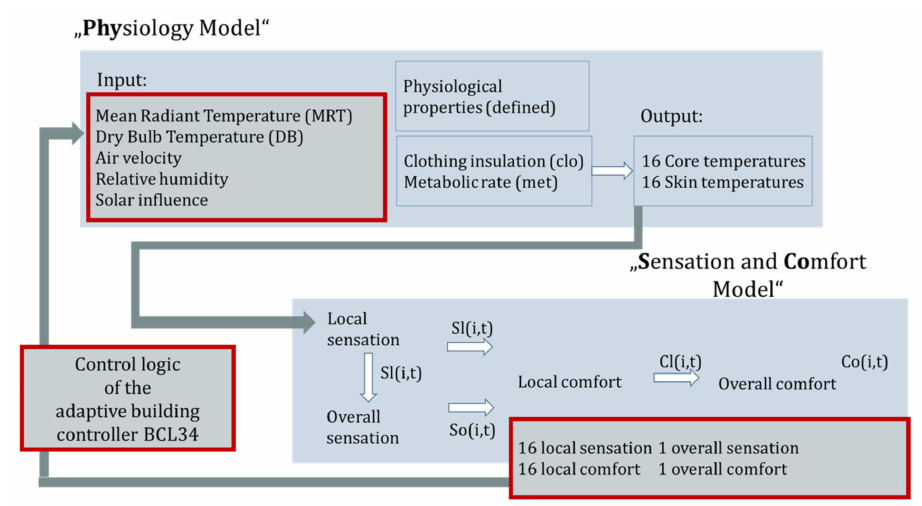
Figure 3. Coupling of PhySCo and Esp-r [51].